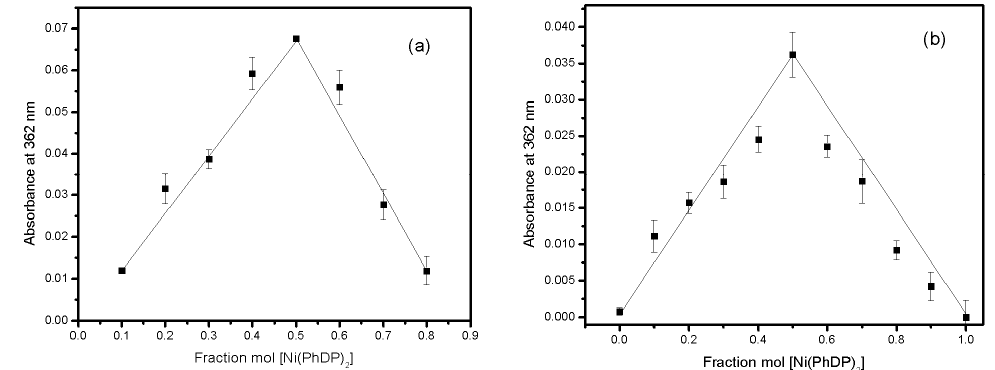
Figure 4. Job plot indicating the 1:1 stoichiometry for the (NiGlyp(PhDP) 2 ) complex, with a total concentration of ( a ) 5 × 10 − 5 mol/L and ( b )1 × 10 − 4 mol/L.